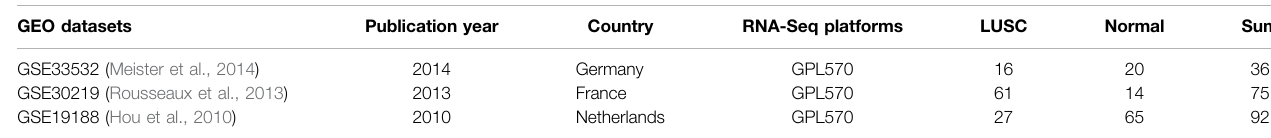
TABLE 1 | Characteristics of the included datasets from GEO.